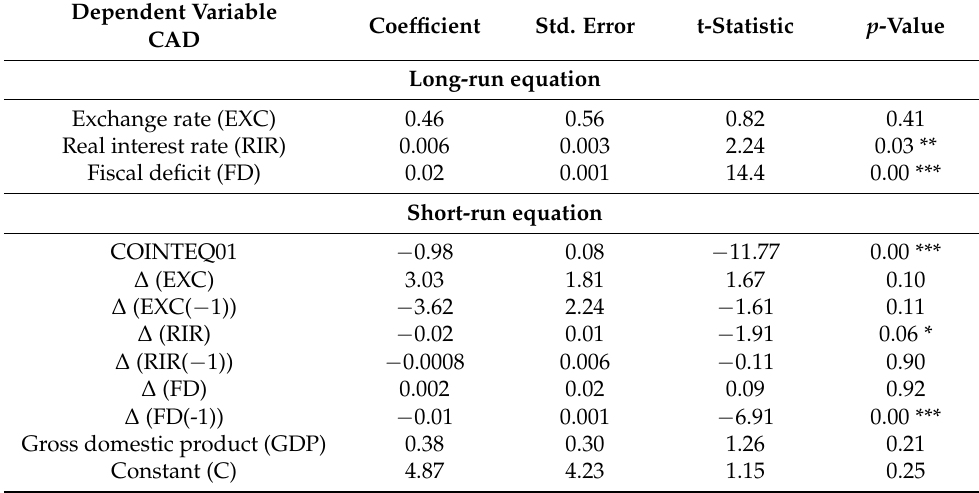
Table 12. Findings of panel auto-regressive distributed lag (ARDL) for higher-income economies